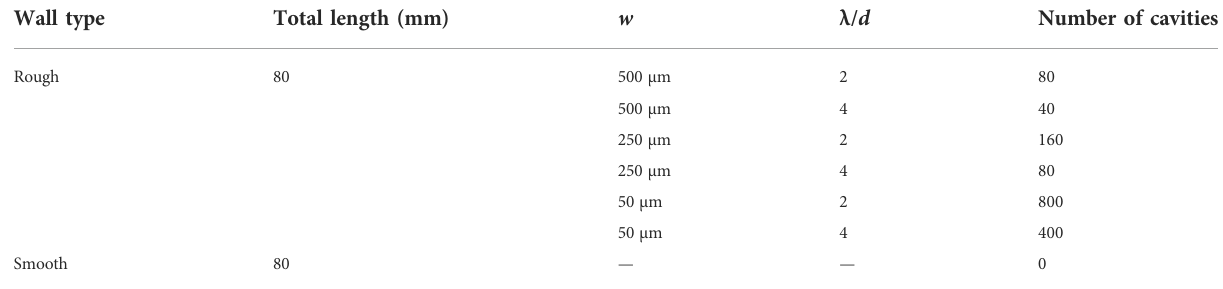
TABLE 1 Geometrical characteristics of considered models.